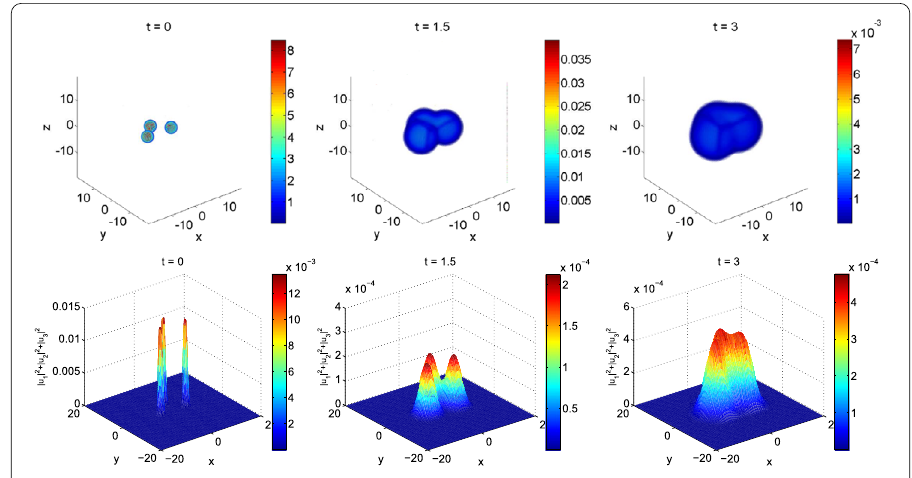
Figure 13 Profile of solutions to 3CNFSE (26) using the spectral ETDRK4-P13 scheme ( α = 1.8, N = 160)